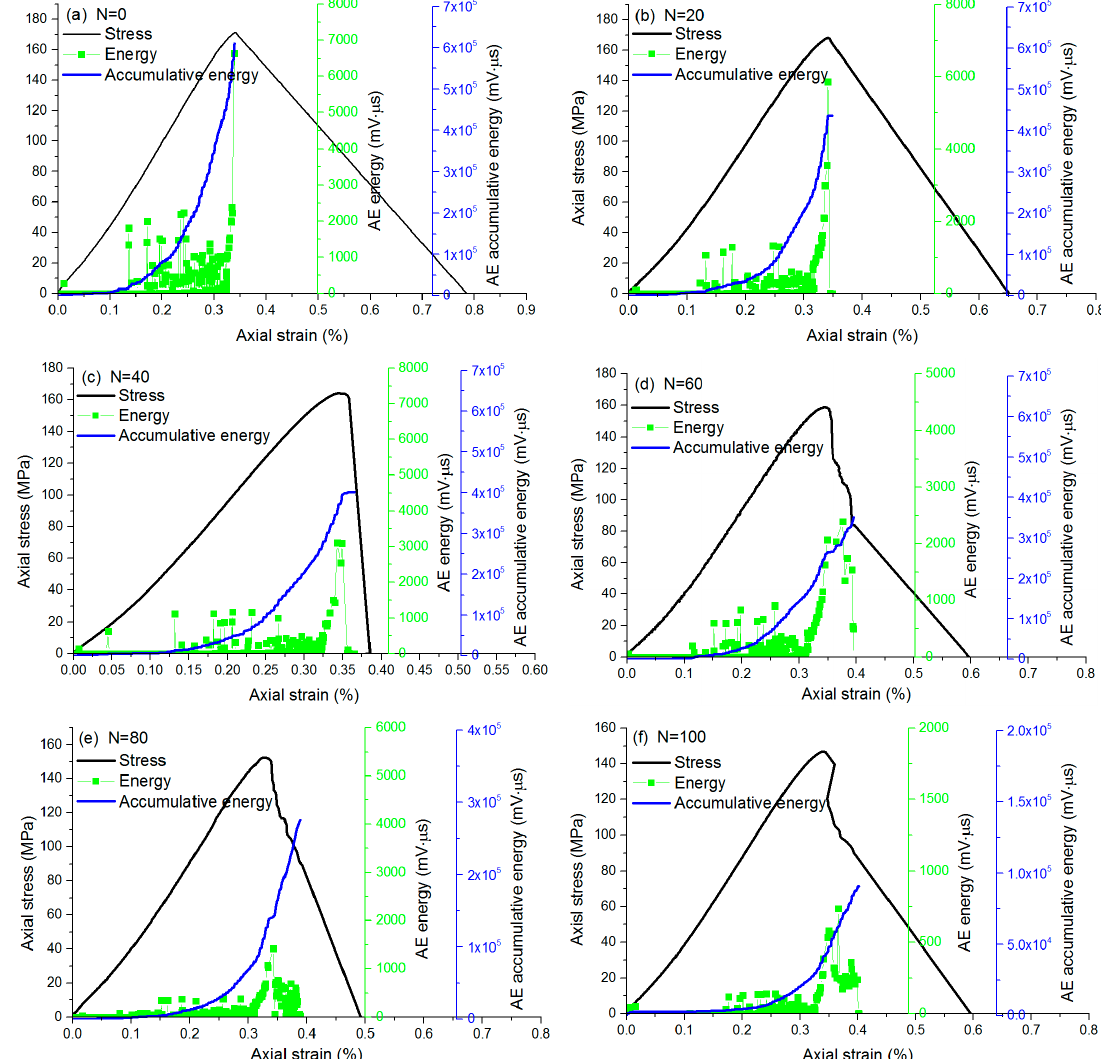
Figure 17. The evolution of AE energy for the granite samples. ( a – f ) AE energy for granite samples subjected to 0, 20, 40, 60, 80 and 100 F–T cycles.